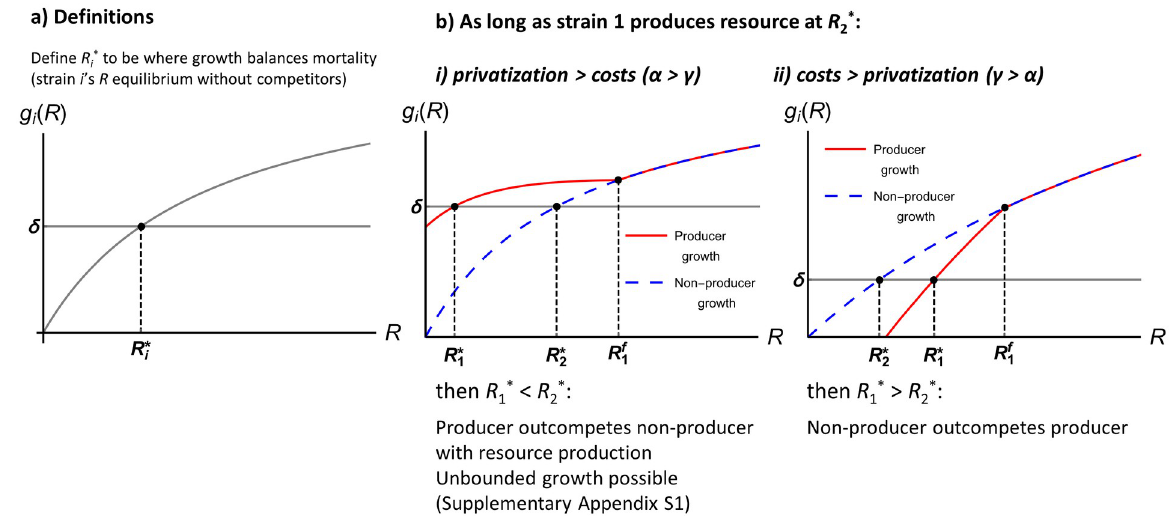
Fig 1. Overview of results from the single-resource model. (a) Graphical representation of single-strain equilibrium R � as a function of resource concentration R . Note that when growth g capita growth rates excluding external mortality g i the cell population is at equilibrium. (b) R f is defined as the resource concentration at which the producer halts production (S1 Appendix). As 1 long as the producer actually produces resources at equilibrium (see S1 Appendix for case where this does not hold), competitive exclusion occurs. i) If privatization is greater than production costs ( α > γ ), then the producer outcompetes the non-producer and resource production is maintained. Note that unbounded growth may occur in this case (see S1 Appendix). ii) If production costs are greater than privatization ( γ > α ), then the non-producer outcompetes the producer and resource production is lost from the